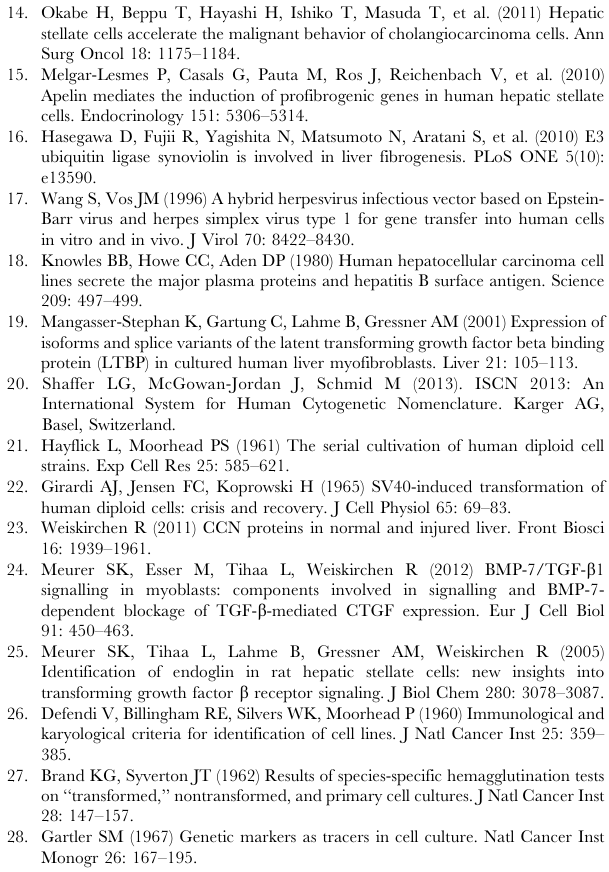
and ‘‘LX2’’. Please note the increasing number of reports using LX-2 cells during recent years. Figure S2 Light microscopic appearance of LX-2. Cells were seeded in cell culture dishes and representative images taken from cultures at (A) high and (B) low densities. Original magnifications are 200 6 (A) and 400 (B), respectively. Space bars in each figure represents 50 m m. Figure S3 LX-2 immunocytochemistry. (A–C) LX-2 cells were incubated with an Alexa Fluor H 488 phalloidin conjugate and nuclei were stained with DAPI. The cells were analysed by UV microscopy for the Alexa dye (A) and DAPI (B) . The overlay of (A) and (B) is shown in (C) . (D–F) LX-2 cells were stained with an antibody specific for a -SMA (D) and nuclei stained with DAPI (E) . The overlay is shown in (F) . (G–I) A stain with an unspecific mouse IgG served as an internal control for antibody specificity. (J–L) LX-2 cells were permeabilized and stained with a polyclonal antibody raised against amino acids 4–30 mapping near the N- terminus of large SV40 T Ag (J) and nuclei stained with DAPI (K) . The overlay of (J) and (K) is shown in (L) . (M–O) A stain with an unspecific control rabbit IgG in this analysis served to demonstrate antibody specificity (E) . Original magnifications are 400x (A–C, G–O) and 200 (D–F) , respectively. Space bars in each figure represents 50 m m. Table S1 Antibodies used in this study.